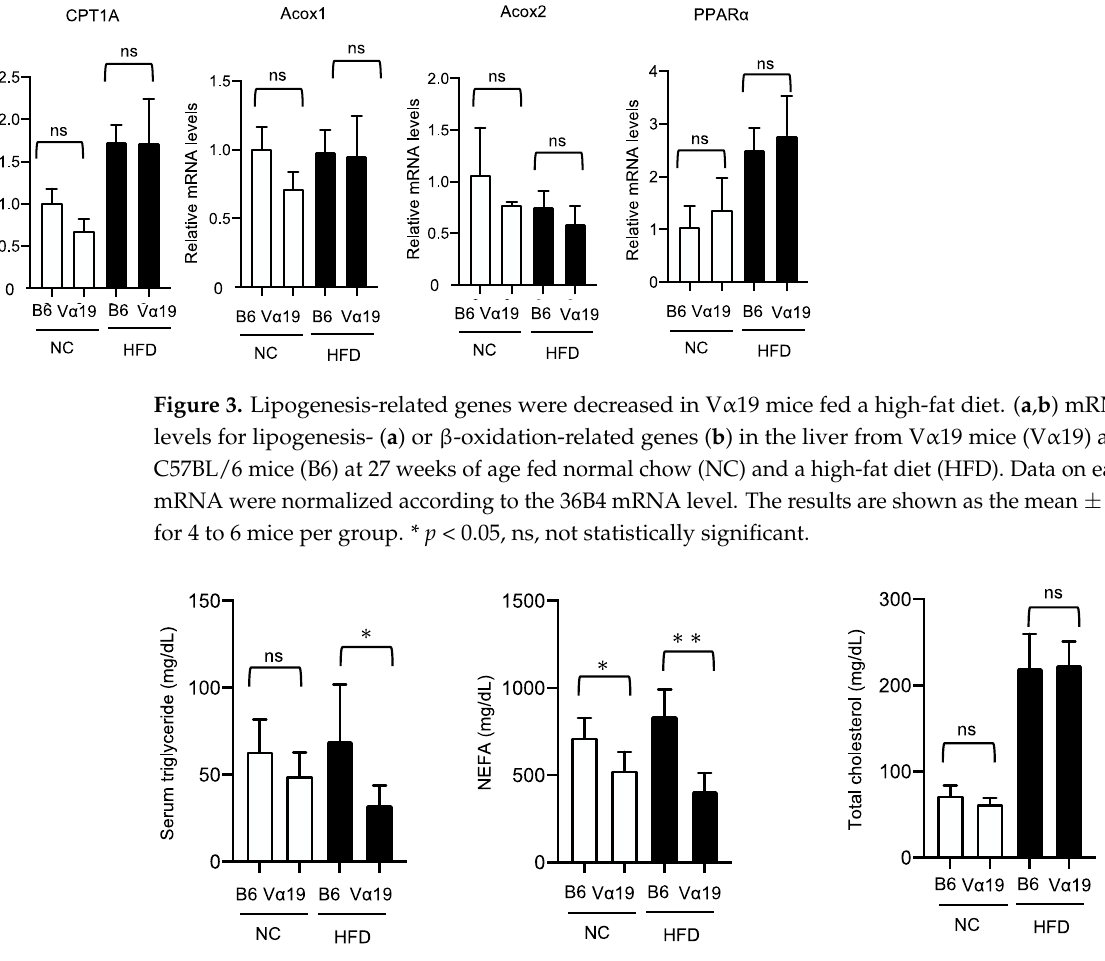
Figure 4. Serum triglyceride and non-esterified fatty acid levels were decreased in V α 19 mice. Serum triglyceride, non-esterified fatty acids (NEFA), and total cholesterol levels in V α 19 mice (V α 19) and C57BL/6 mice (B6) at 27 weeks of age fed normal chow (NC) and a high-fat diet (HFD). The results are shown as the mean ± SD for 7 to 9 mice per group. * p < 0.05, ** p < 0.005, ns, not statistically significant.